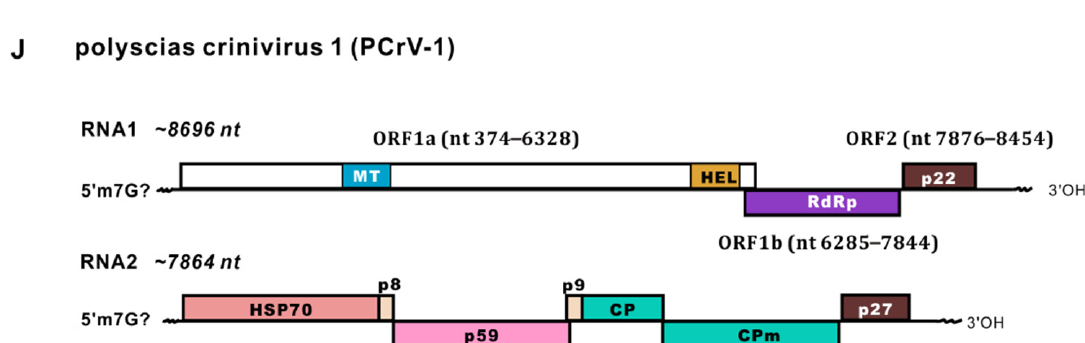
Figure 1. ( A – G ) Polyscias balfouriana samples of different cultivars with different morphologies col- lected from Xinglong Tropical Botanical Garden, Hainan Province, China; ( H – J ) schematic repre- sentation of the genomic organisation of three newly identified RNA viruses. Most of the samples